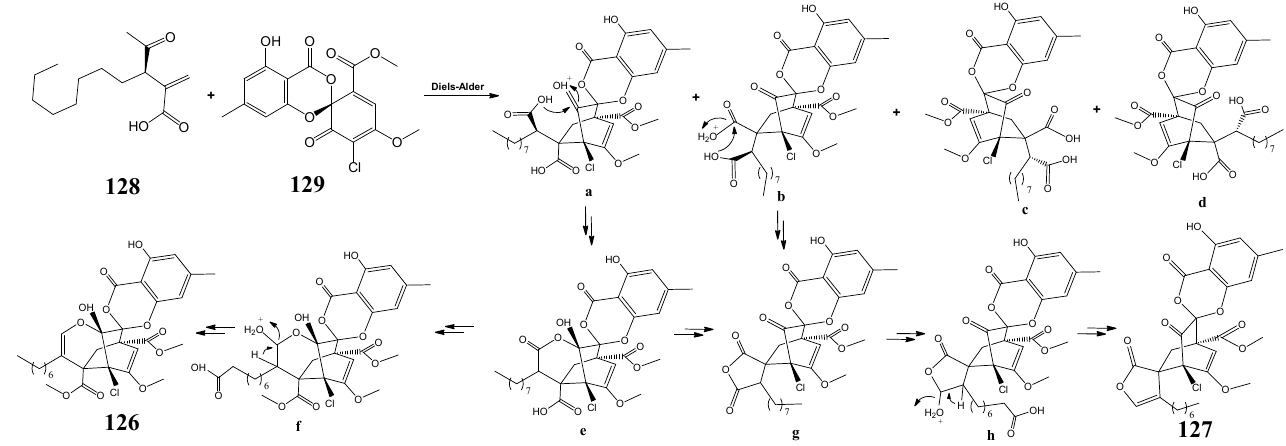
Figure 3. The hypothetical biosynthetic pathways for c hlorotheolides [170]. Chlorotheolides A ( 126 ) and B ( 127 ) exhibited weak inhibitory effects on two human tumor cell lines, HeLa (cervical carcinoma) and MCF-7 (breast adenocarcinoma), with IC 50 values of 13.3–73.2 μM, compared to the positive control cisplatin (IC 50 values of 4.7 and 4.9 μM, respectively), and chlorotheolides B ( 127 ), which was found to inhibit cell viability in a time- and dose-dependent manner; however, 1-undecene-2,3-dicarboxylic acid ( 128 ) and maldoxin ( 129 ) did not display detectable activity against the tested tumor cell lines at a concentration of 20 μg/mL [170].